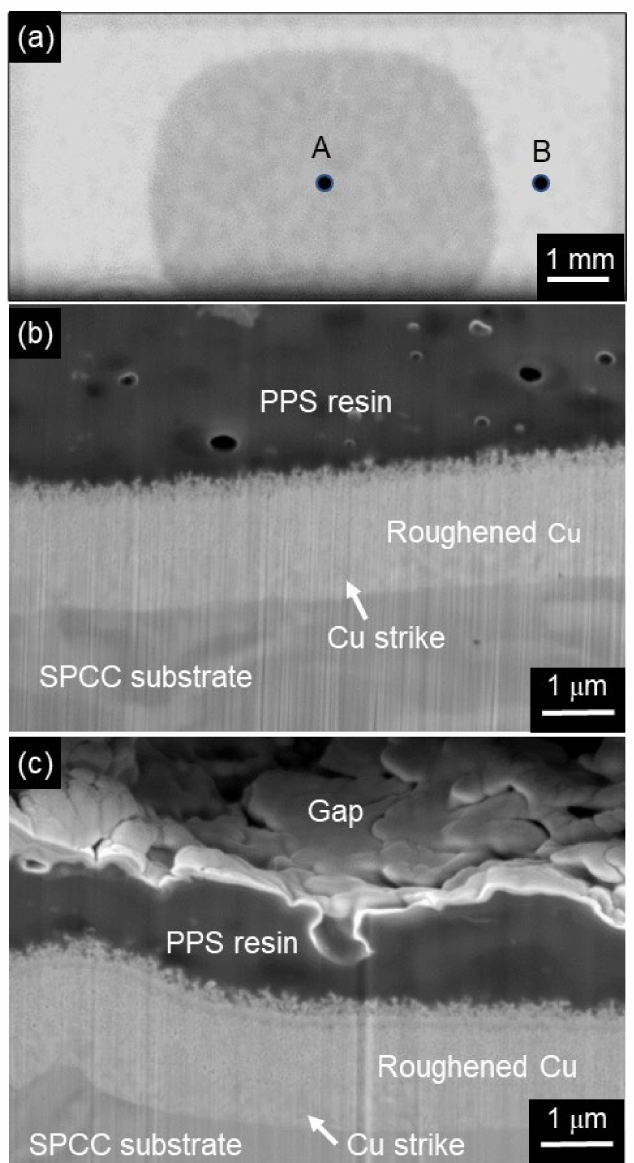
Figure 13. Cross-sectional SEM images of the boundaries of non-shear-tested bonded sample D after the thermal shock test: ( a ) SAT image of bonded sample D after thermal shock testing; points A and B are cross-sectional analysis points. ( b , c ) Cross-sectional SEM images at points A and B,